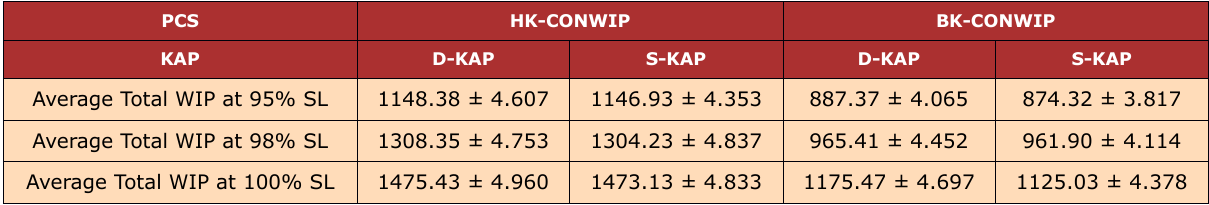
Table 9. Case-2 Optimisation results of PCS+KAP for average total WIP with 95% confidence interval half widths at targeted service levels